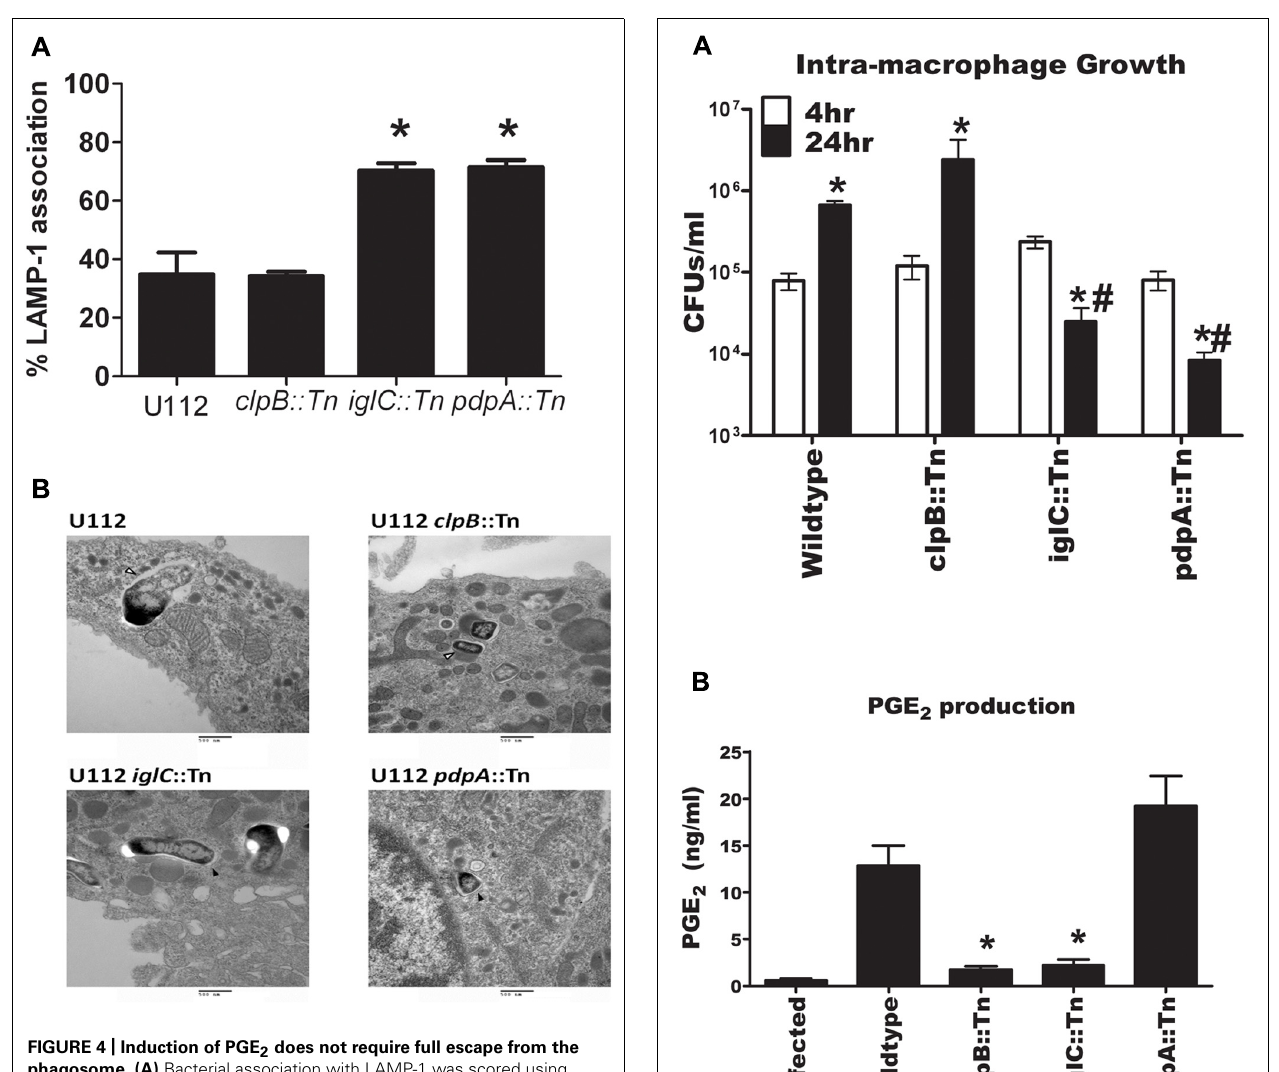
the concentration of PGE 2 in supernatants was determined at 24